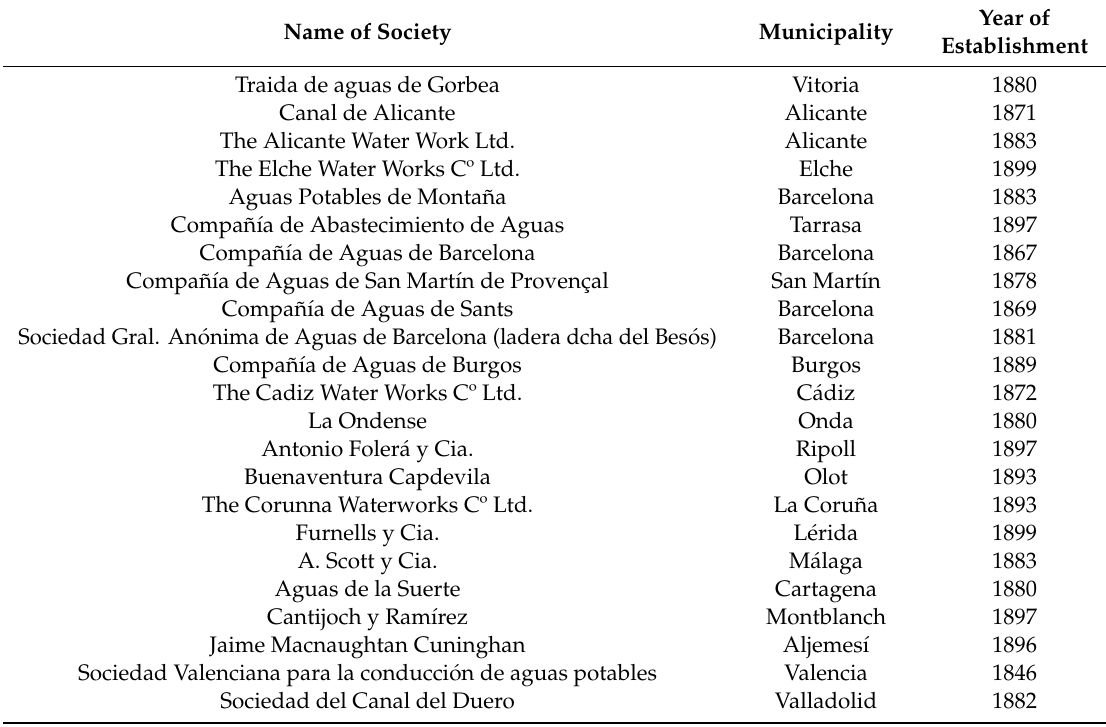
Table 7. Companies established in the 19th century and which did not operate for more than 20